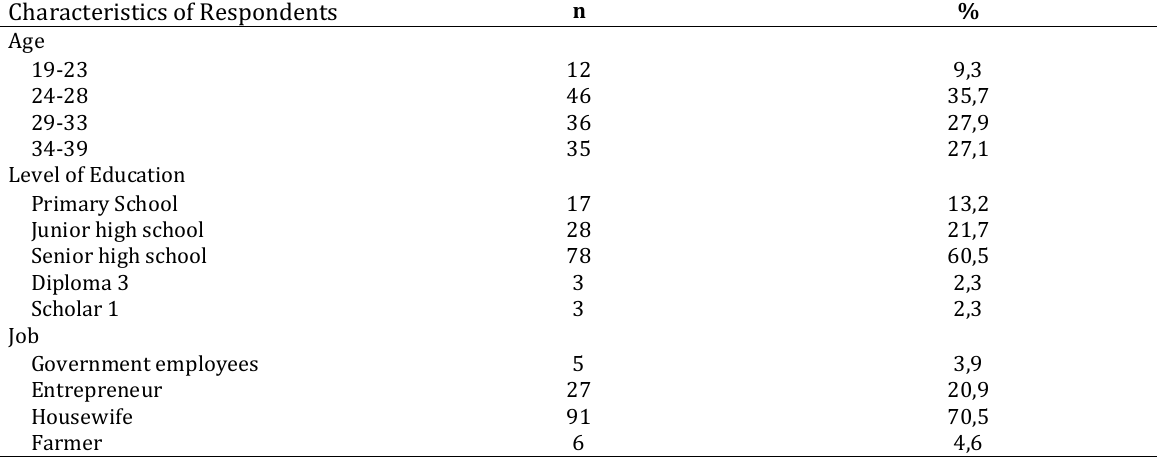
Table 1. Characteristics of Respondents (n=129) Characteristics of Respondents